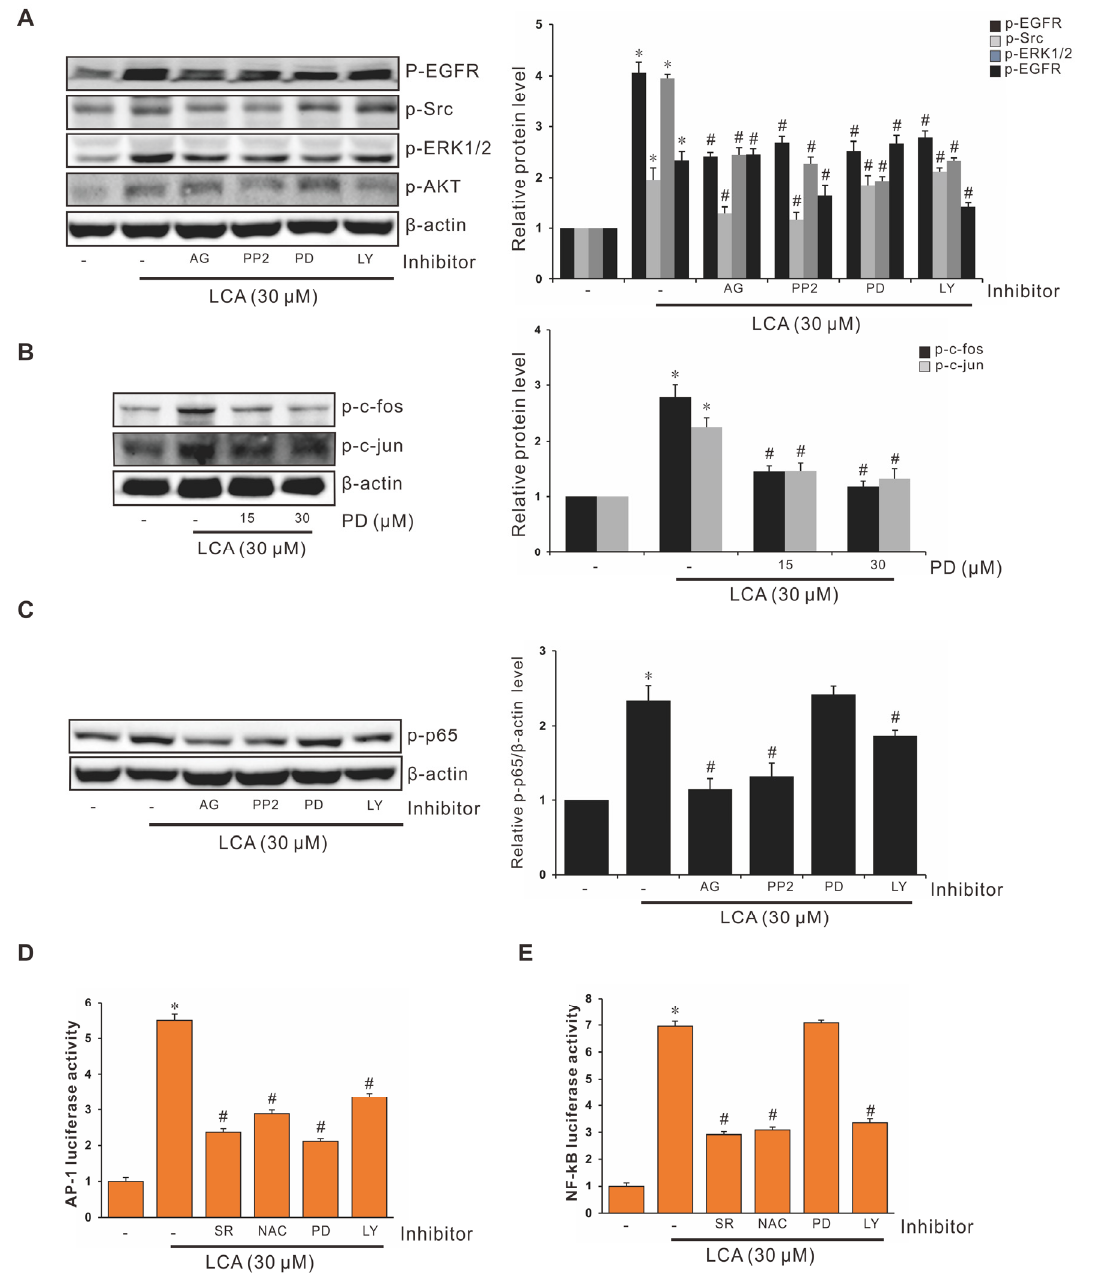
Figure 5. Effect of Inhibitors on Expression of EGFR, Src, ERK, and AKT in HCT-116 Cells. ( A ) HCT- 116 cells pretreated with 10 μ M AG1478 (AG), 10 μ M PP2, 30 μ M PD-98059 (PD), or 20 μ M LY- 294002 (LY) for 1 h were incubated with 30 μ M LCA, and cell lysates were analyzed for the phosphorylation level of EGFR, Src, ERK1/2, and AKT using western blotting. ( B ) HCT-116 cells pretreated with PD for 1 h were incubated with 30 μ M LCA, and cell lysates were analyzed for the phosphorylation level of c-Fos and c-Jun through western blot analysis. ( C ) HCT-116 cells pretreated with AG, PP2, PD, or LY for 1 h were treated with 30 μ M LCA, and cell lysates were analyzed for the phosphorylation level of p65 using western blot analysis. HCT-116 cells were transiently transfected with AP-1 luciferase reporter construct ( D ) or NF- κ B luciferase reporter construct ( E ). These transfected cells were pretreated with 2 μ M SR-11302 (SR), 5 mM N -acetyl- L -cysteine (NAC), 30 μ M PD, 20 μ M LY, or 10 μ M BAY-11-7082 (BAY) for 1 h and incubated with 30 μΜ LCA for 4 h, and the luciferase activity was measured using a luminometer. Data represent the mean ± SEM from three experimental trials. * p < 0.05 versus control; # p < 0.05 versus LCA.